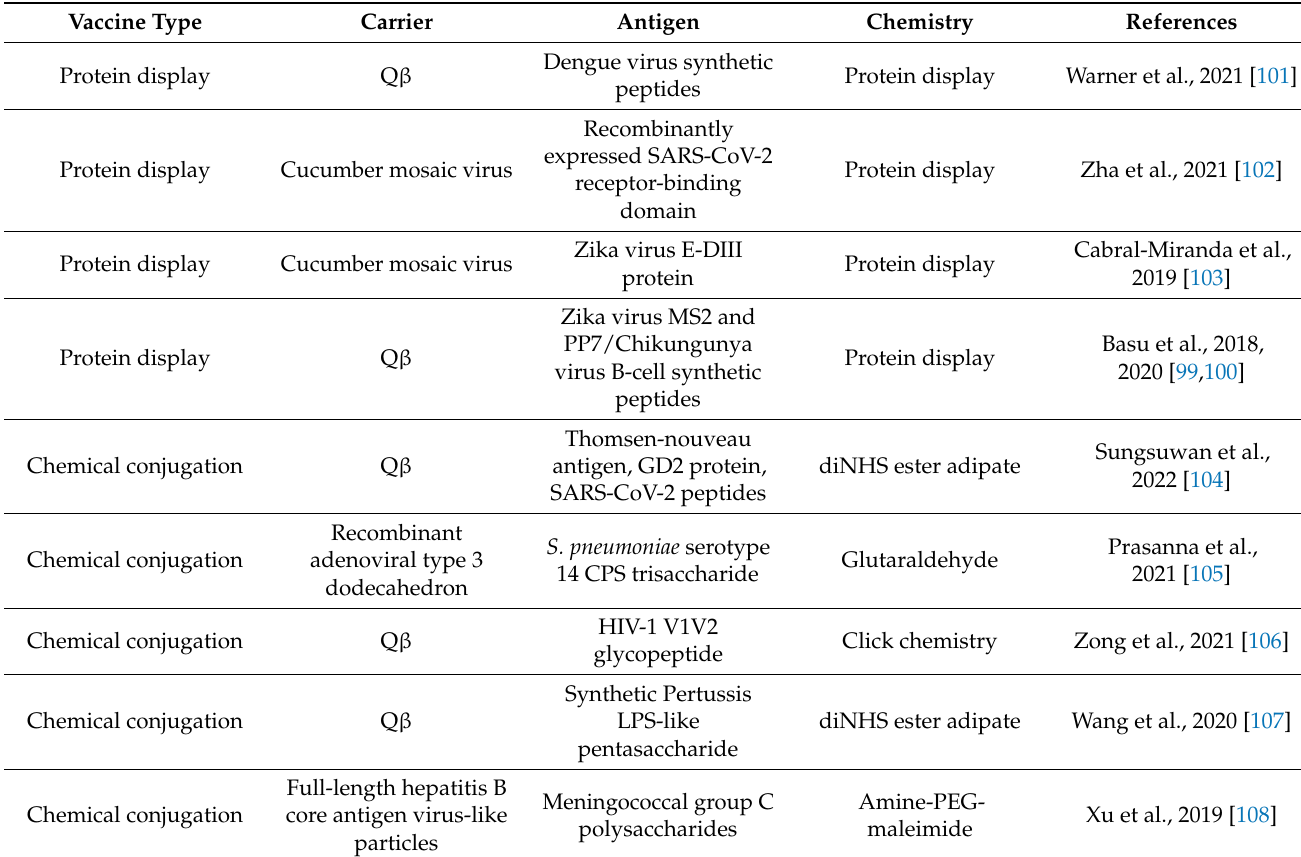
Table 4. VLP conjugation